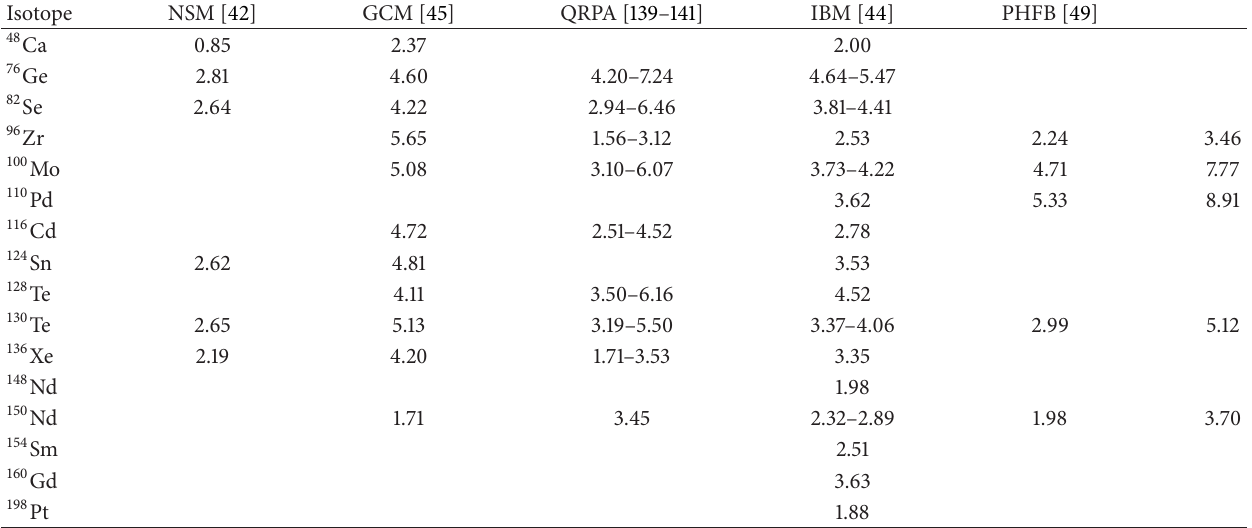
Table 2: Theoretically evaluated 𝛽𝛽(0 ] ) matrix elements 𝑀 0 ] according to different authors and methods. Where needed, values have